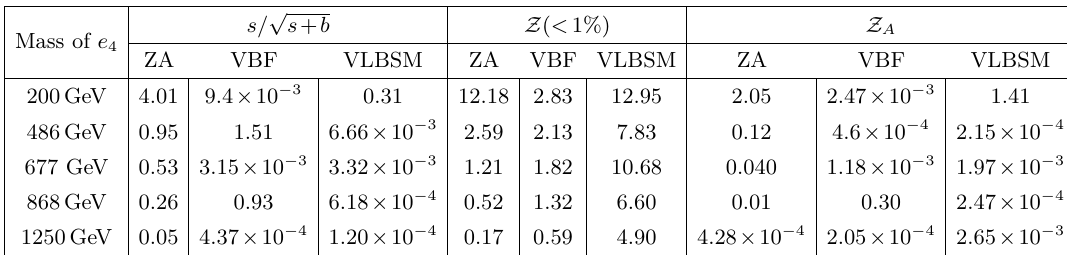
Signal significance for an evolutive algorithm that maximizes accuracy metric. All significances are computed for L = 3000 fb − 1 .